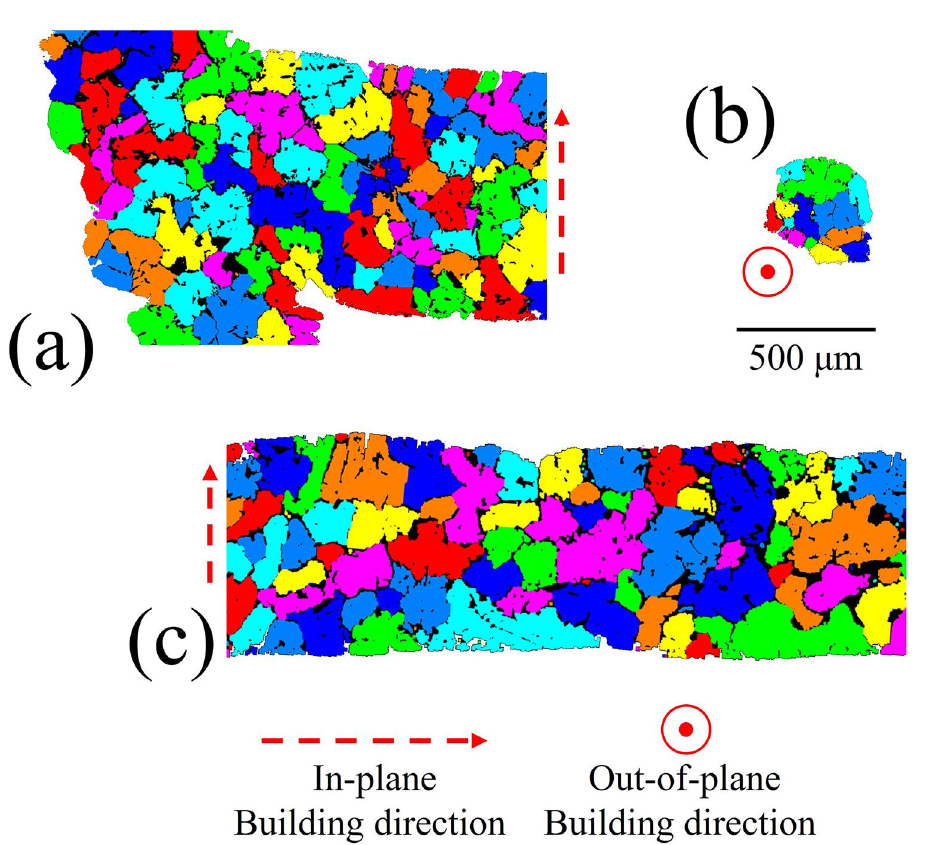
Figure 6. Representative detail of the α-Al grains in the vicinity of ( a ) a cell corner, ( b ) a vertical strut and ( c ) a horizontal rib. The grains were thresholded using Avizo Standard and the random choice of colours used to denote each grain, are not representative of the crystalline orientation of each